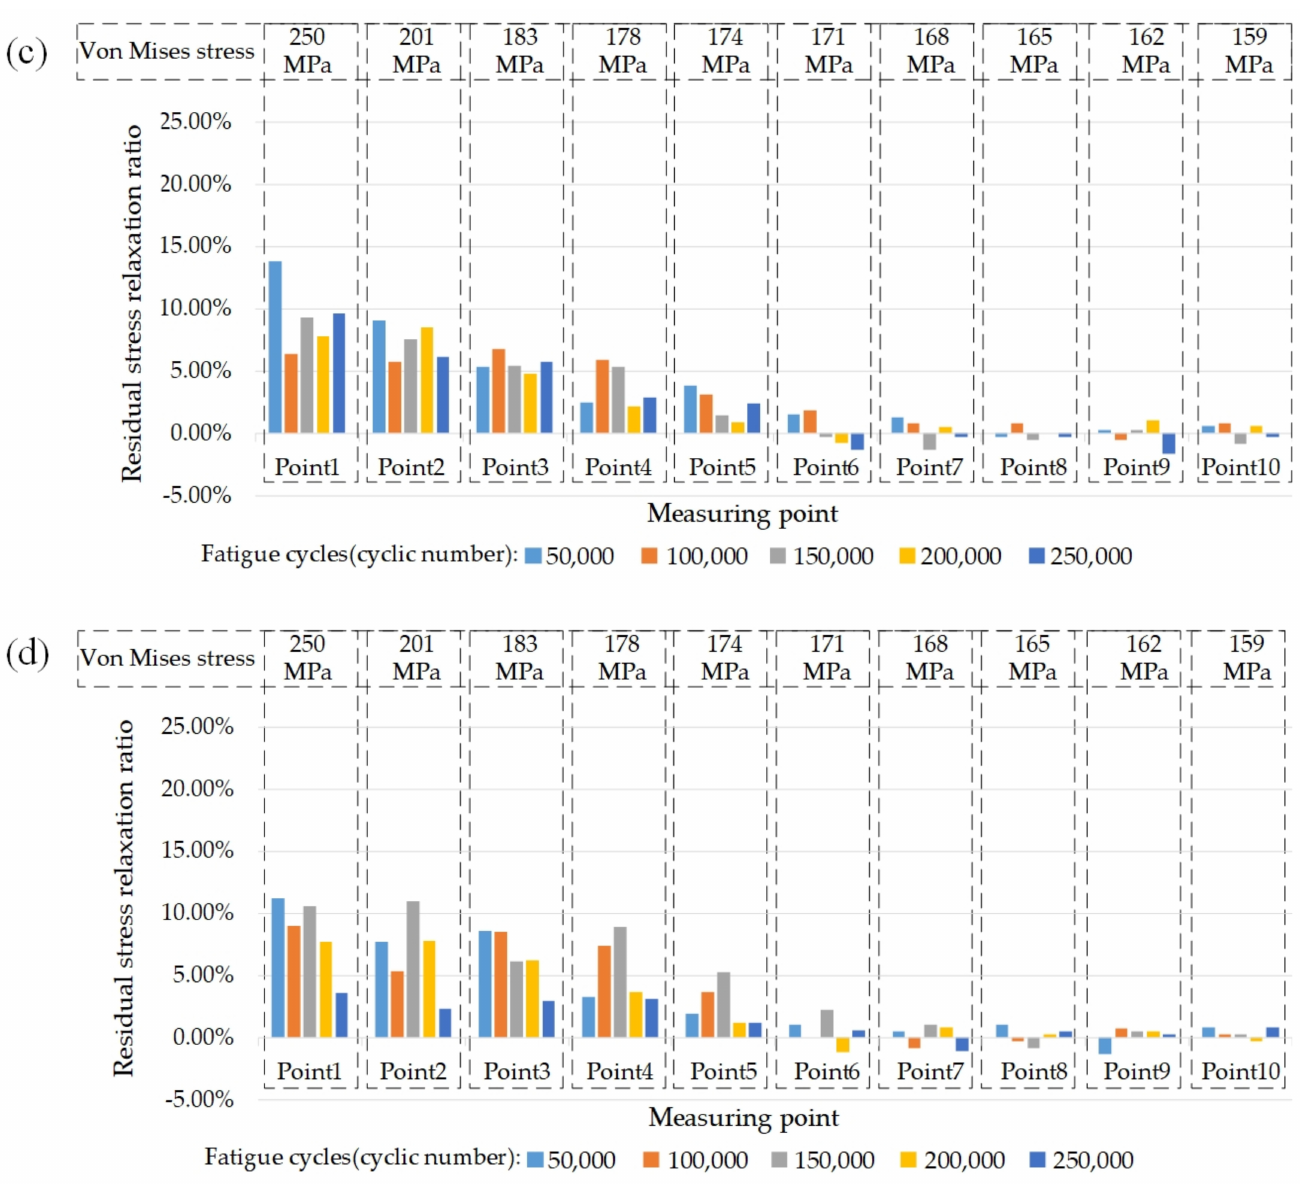
Figure 19. The residual stress relaxation ratio of ( a ) P2, ( b ) P3, ( c ) P4, and ( d )